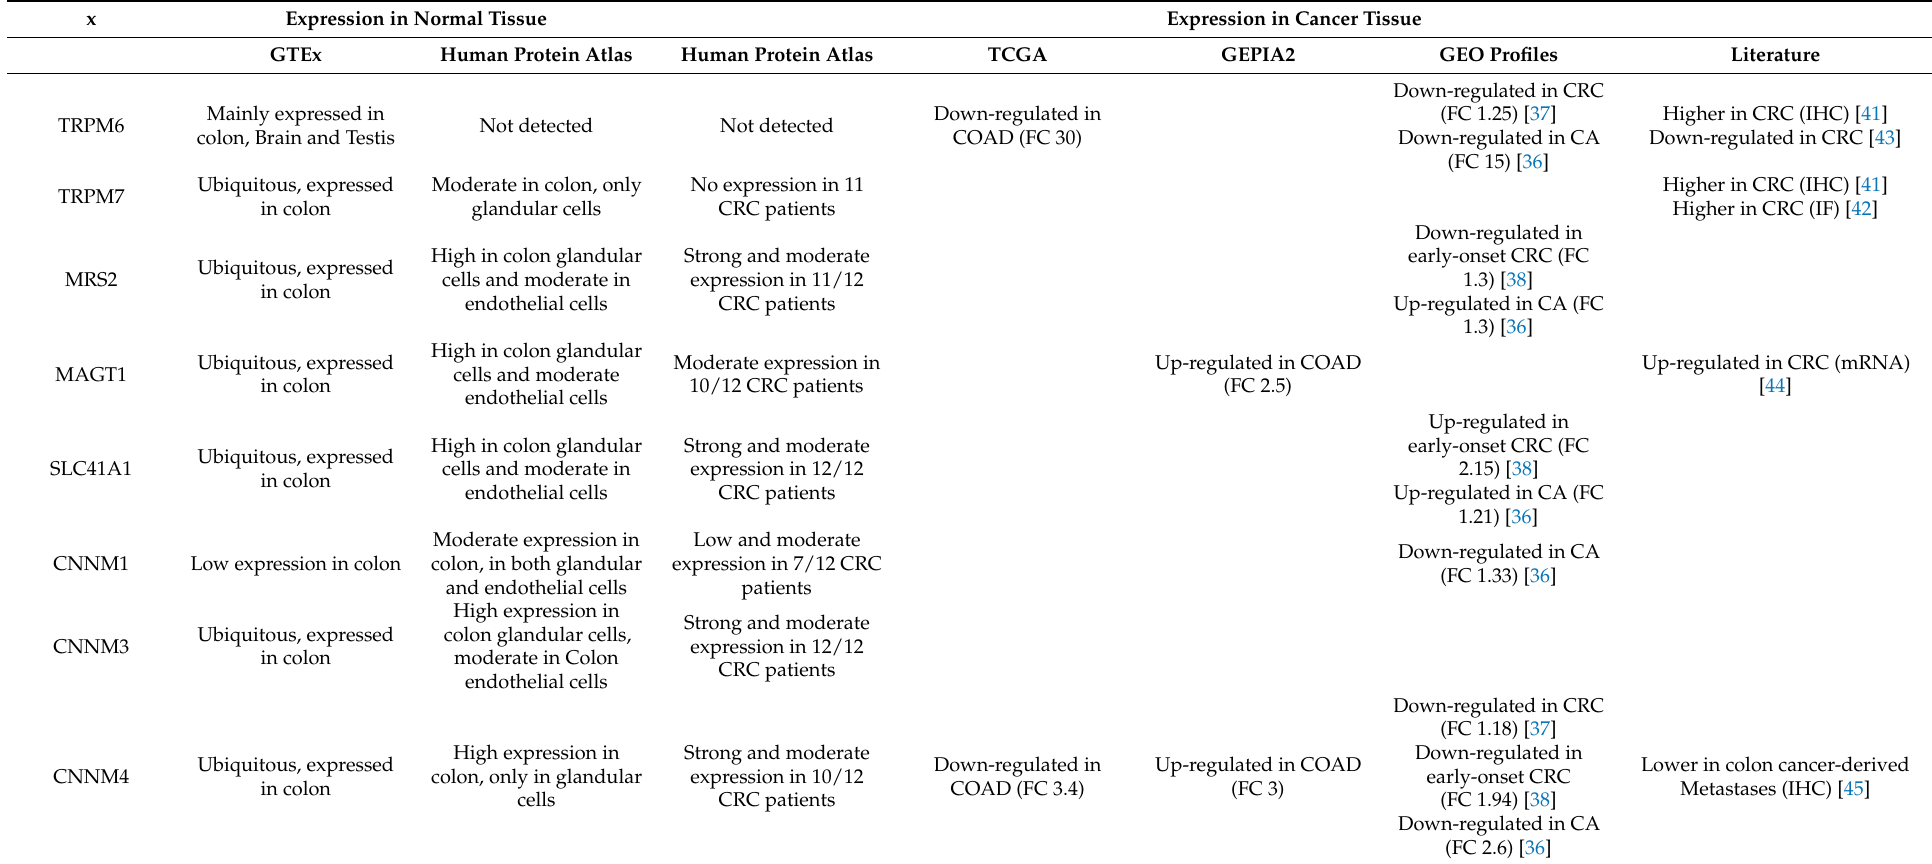
Table 1. Gene and protein expression profiles of Mg channels and transporters in